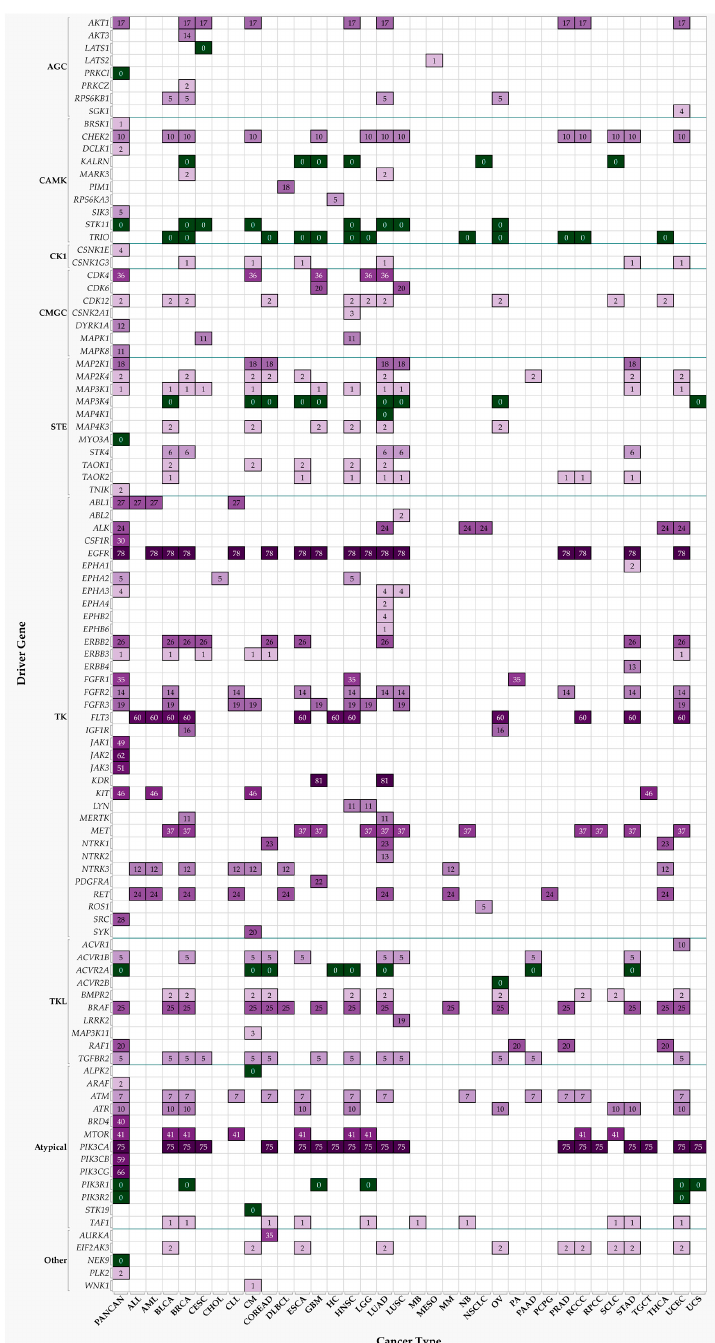
Figure 1. Protein kinase drivers of various cancer types as targets for pharmacological inhibitor development. Heatmap depicts established associations of protein kinases as drivers of certain types of cancer, including those that are additionally targets of active inhibitor drug development [9,27,30]. Numbers indicate amounts of available pharmacological inhibitors or negative allosteric modulators, also depicted in shades of purple, while green indicates a lack thereof. ALL: Acute Lymphocytic Leukemia; AML: Acute Myeloid Leukemia; BLCA: Bladder Carcinoma; BRCA: Breast Carcinoma; CESC: Cervical squamous cell carcinoma and endocervical adenocarcinoma; CHOL: Cholangiocar- cinoma; CLL: Chronic Lymphocytic Leukemia; CM: Cutaneous Melanoma; COREAD: Colorectal Adenocarcinoma; DLBC: Lymphoid Neoplasm Diffuse Large B-cell Lymphoma; ESCA: Esophageal Carcinoma; GBM: Glioblastoma; HC: Hepatocellular Carcinoma; HNSC: Head and Neck